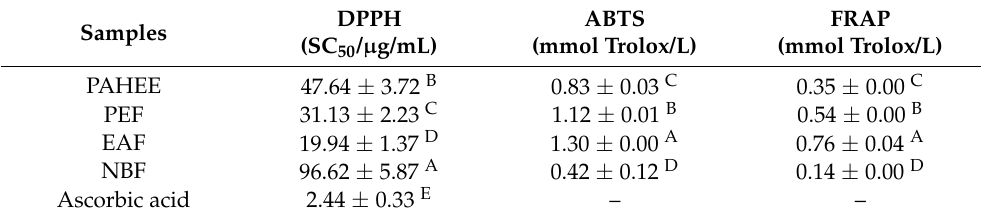
Table 3. Antioxidant activities of PAHEE and its fractions via assays for DPPH, ABTS, and FRAP. Samples